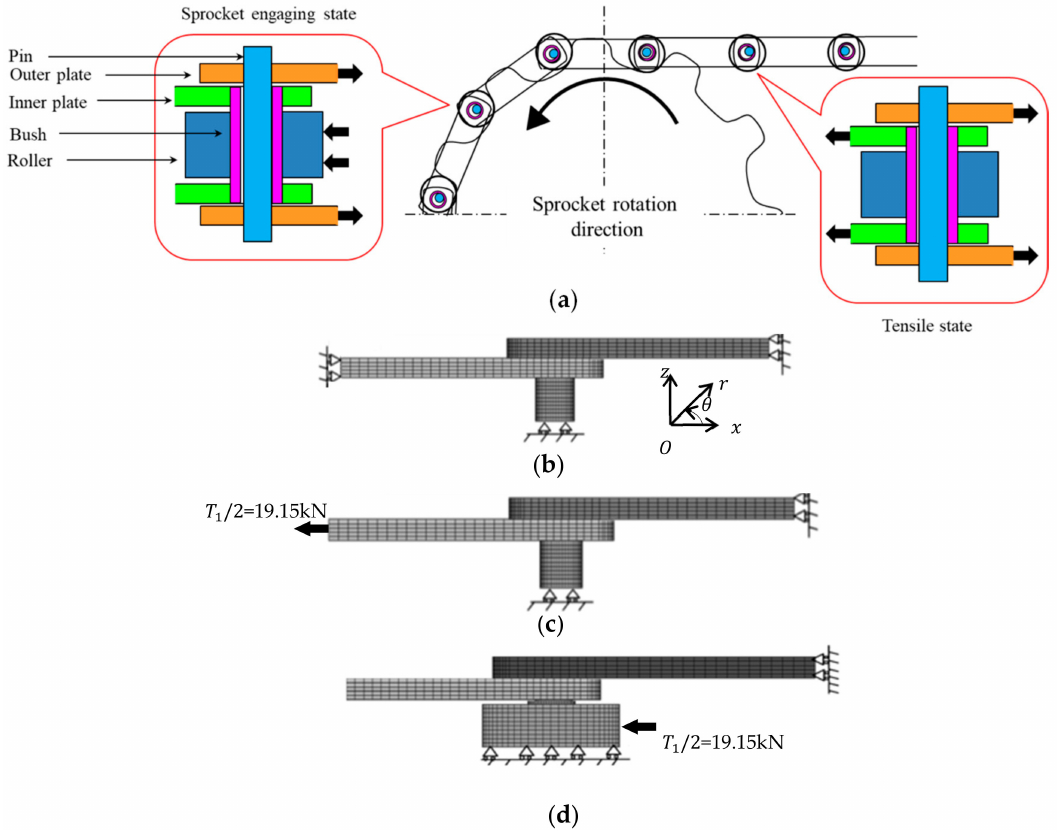
Figure 3. Schematic illustration of the roller chain drive system and the FEM model and boundary conditions for roller chain system: ( a ) roller chain drive system; ( b ) press-fitting state (state 1 (cid:13) ); ( c ) tensile state (state 2 (cid:13) ); ( d ) sprocket-engaging state (state 3 (cid:13)